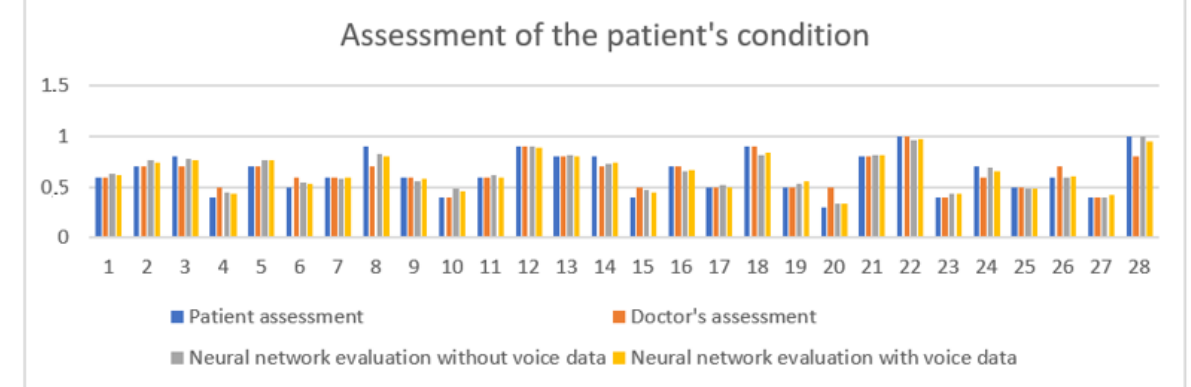
Figure 7. Estimates of the condition of patients.